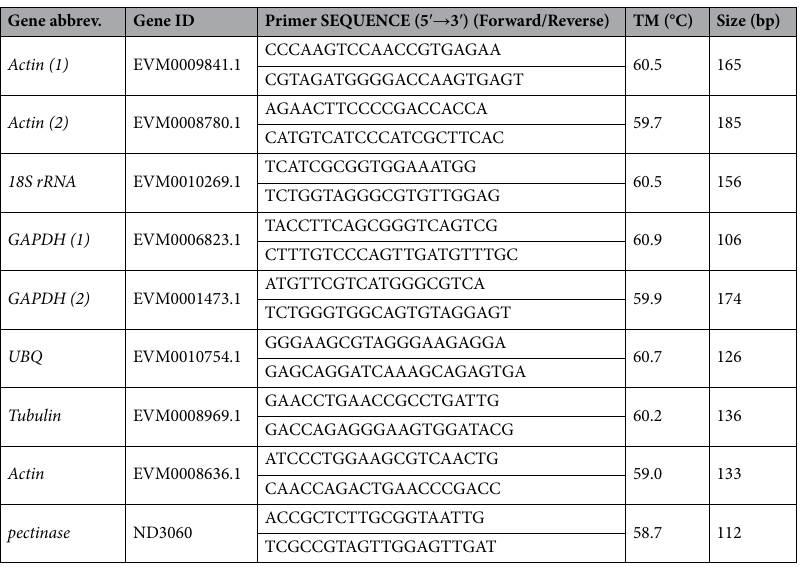
Table 1. Primers of the candidate reference genes use in this study. Gene ID, primer pair sequences and characteristics, and expected amplicon sizes. Gene abbreviations are used to refer to each candidate reference